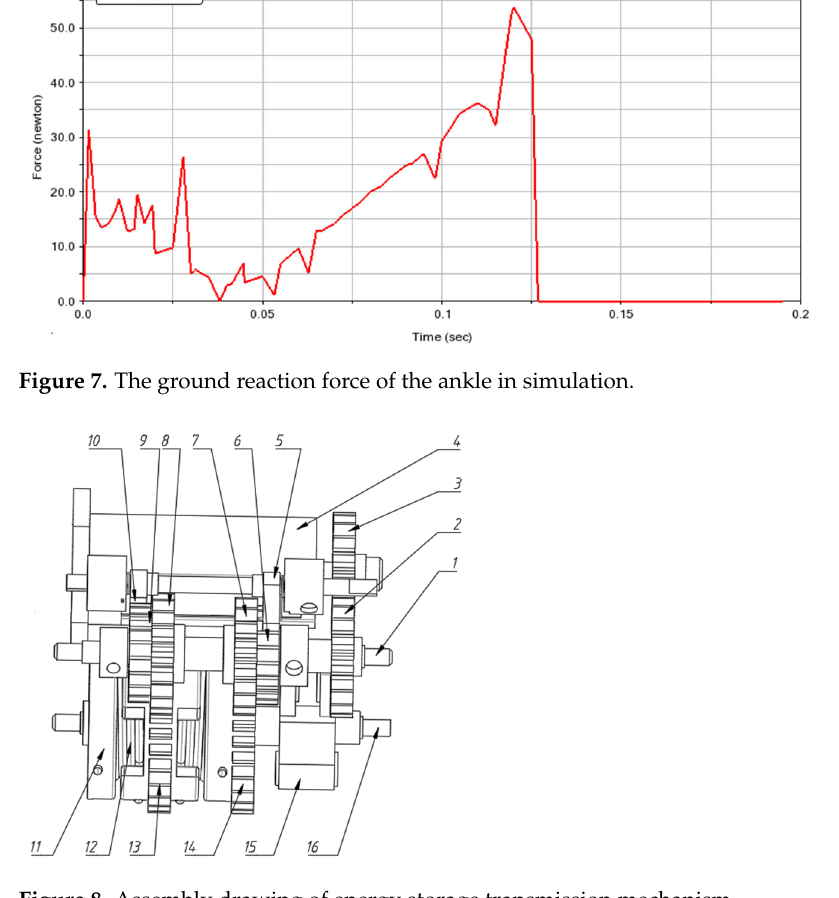
Figure 8. Assembly drawing of energy storage transmission mechanism.